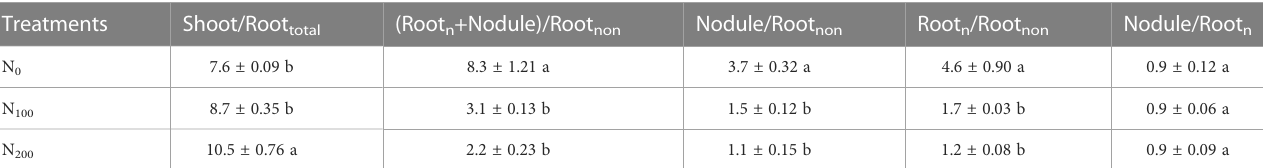
TABLE 4 13 C accumulation distribution ratio between organs of dual-root soybeans. Treatments